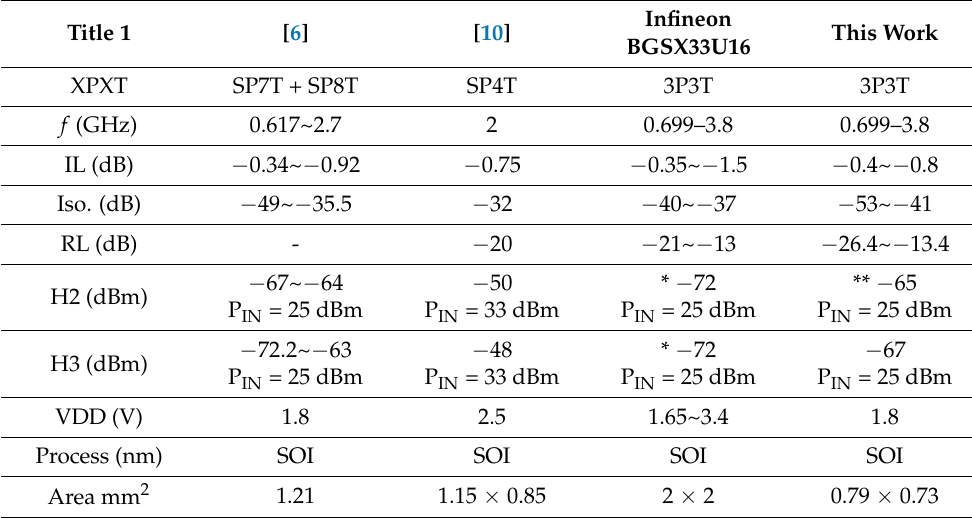
Table 1. Summary of performance